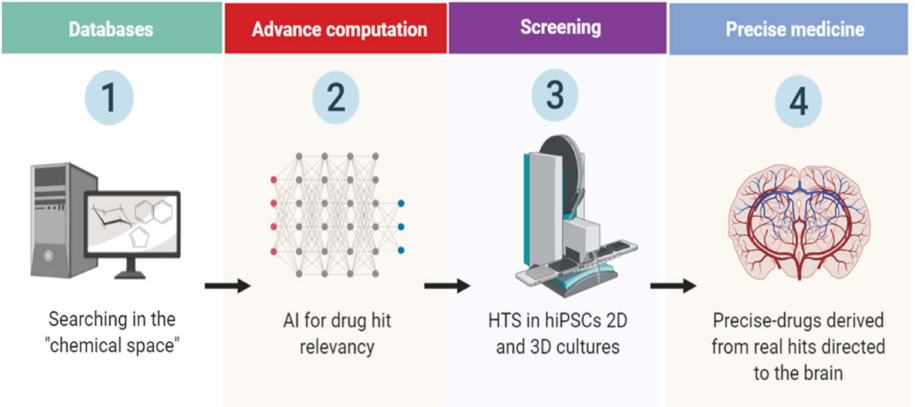
Figure 2. Flowchart of novel drug discovery in neurological disorders. The chemical space can be exploited by artificial intelligence (AI) advanced computational programs leading to better outcomes in drug hit discovery, performed in hiPSCs 2D–3D neuronal platforms. Therefore, the screening of novel targets is a highly dynamic process, based in the testing of thousands of compounds throughout di ff erent developmental stages in